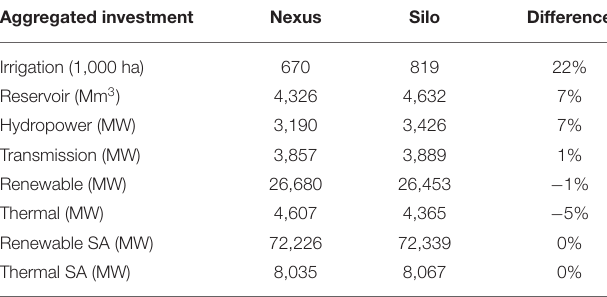
TABLE 3 | Average investment capacity per investment type for the silo and nexus frameworks.